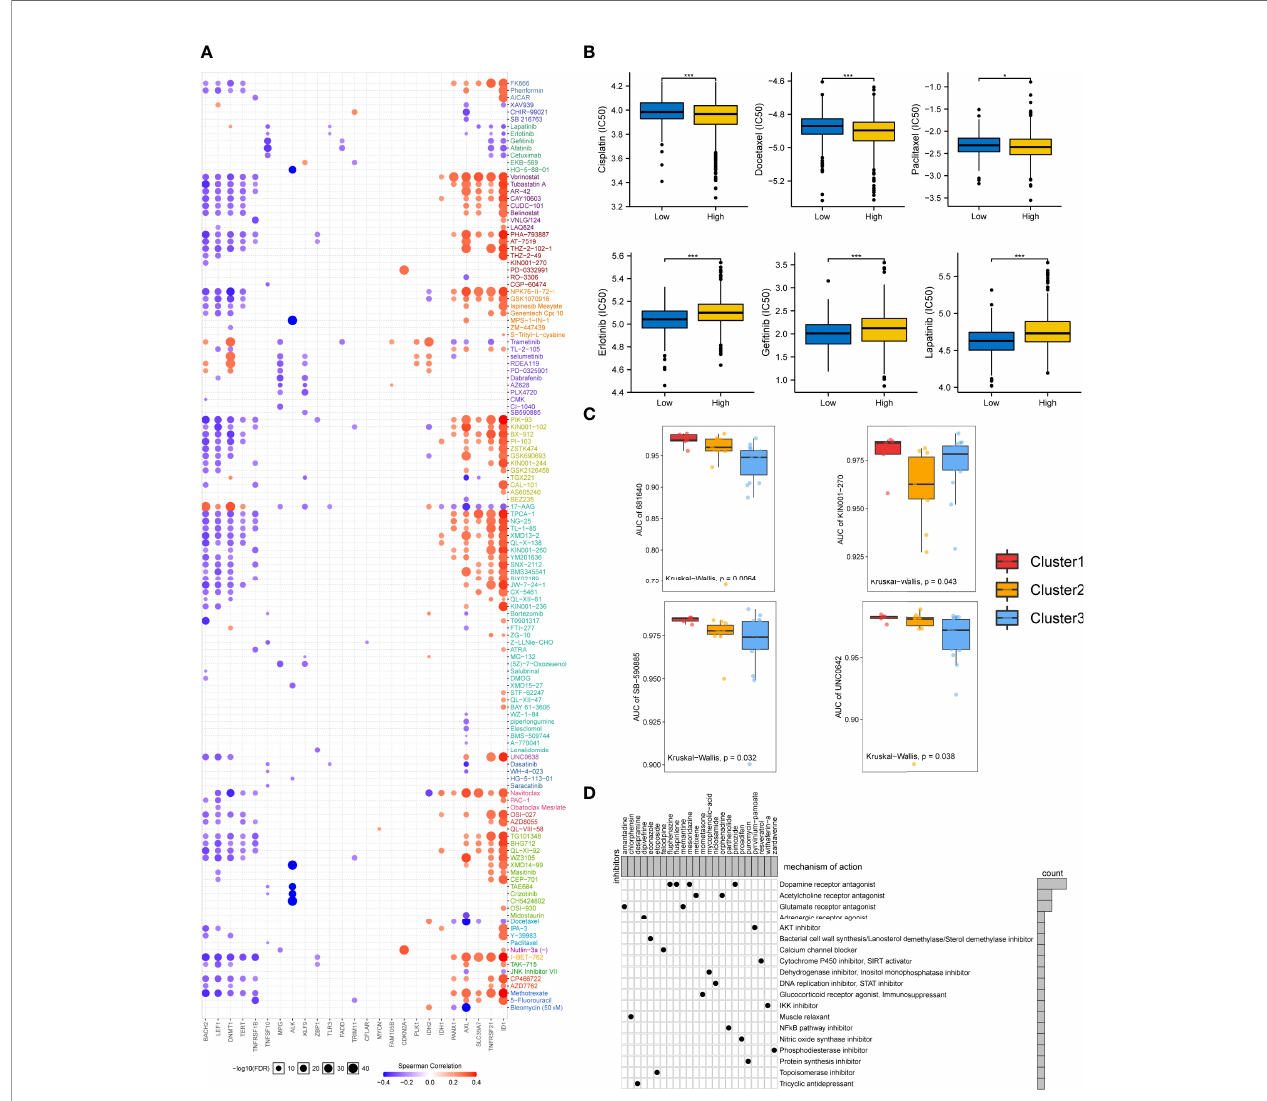
FIGURE 7 | Drug sensitivity in necroptosis-based subtypes and correlation between chemotherapeutic potential and the NecroScore. (A) . The bubble diagram illustrated the results of correlation analysis of the necroptosis regulatory molecules on resistance to common clinical chemotherapeutics. Red indicated positive correlations, meaning that overexpressed mRNA levels of the necroptosis-related molecules were resistant to the drug and vice versa. The darker the color, the larger the correlation coef fi cients. The bubble size denoted the negative value of log10 of false discovery rate (FDR). (B) . A Wilcoxon test showed the differences in half-maximal inhibitory concentration (IC50) between the low- and high-NecroScore groups. Asterisks indicated p-value (***p < 0.001, *p < 0.05). (C) . Differences of the area under the curves (AUCs) of drug response among the three lung adenocarcinoma cell line clustering subtypes were revealed by Kruskal-Wallis test. (D) . The heatmap showed each potential compounds sharing mechanisms of action (MoA, in rows) and sorted by descending number of compound with shared MoA shown in the right bar